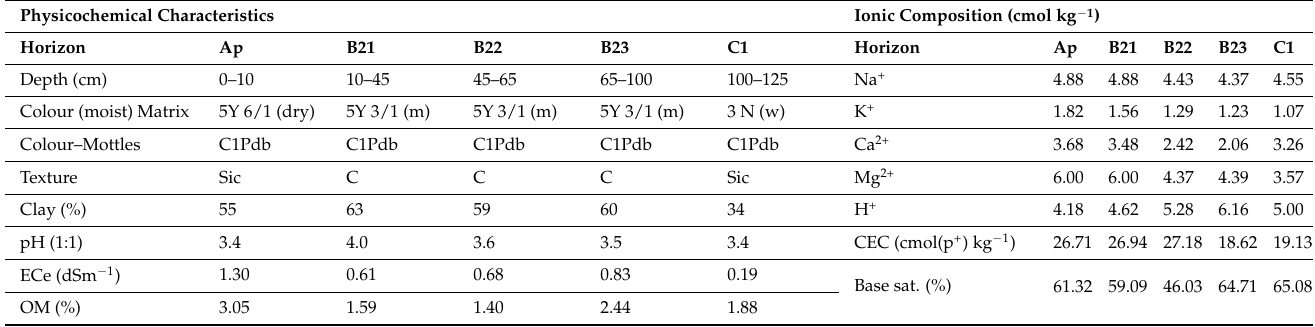
Table 3. Characteristics of acid sulphate soils of Bangladeshi part of the Ganges